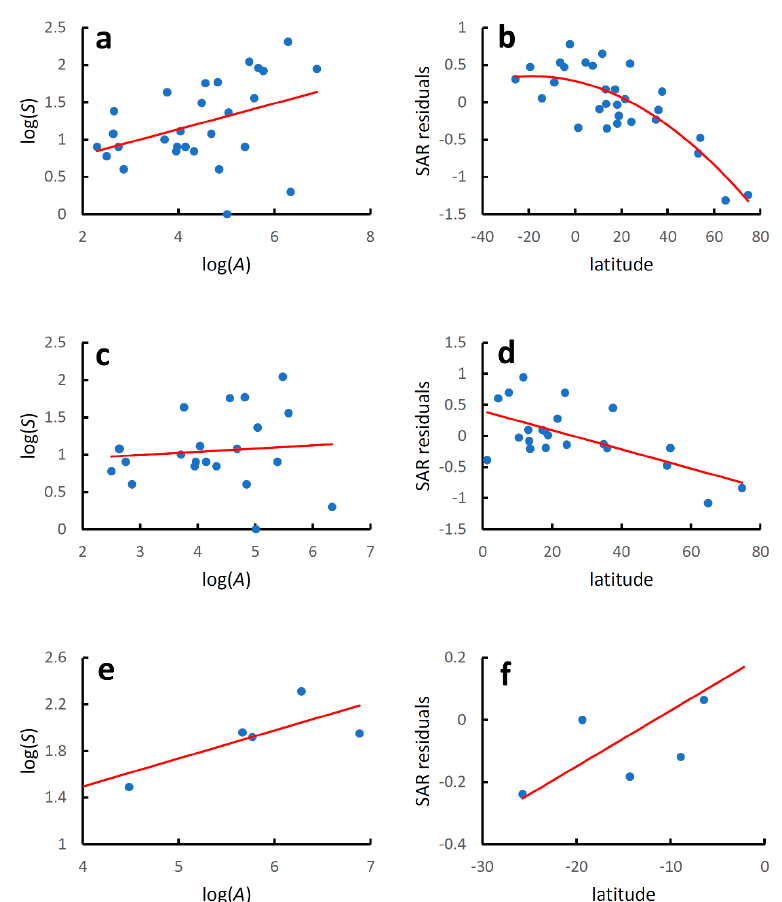
Figure 3. Earwig species–area relationships and latitudinal diversity gradients for world island countries. Species–area relationships were modelled using the linearized version of the power function: log( S ) = z log( A ) + log( c ), where S is the recorded species richness at country level, A is country area (km 2 ), and z and c are estimated parameters. Latitudinal gradients were modelled regressing residuals from the species–area relationships (SAR residuals) against country latitude with a second-order polynomial regression for the whole dataset and with linear regressions for the two hemispheres separately. ( a ) Global species–area relationship; ( b ) global latitudinal gradient; ( c ) species–area relationship for the Northern Hemisphere; ( d ) latitudinal gradient for the Northern Hemisphere; ( e ) species–area relationship for the Southern Hemisphere; ( f ) latitudinal gradient for the Southern Hemisphere. Regression equations are given in Table 3.